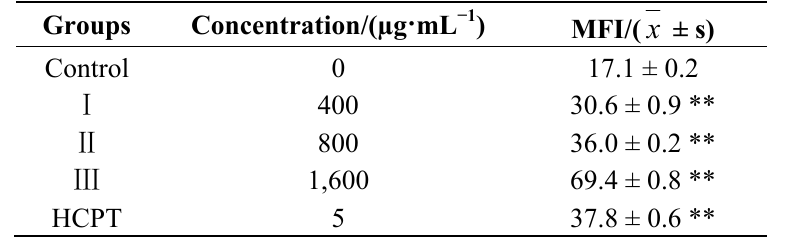
Table 1. Effect of laminaran on ROS of LOVO cells by FCM